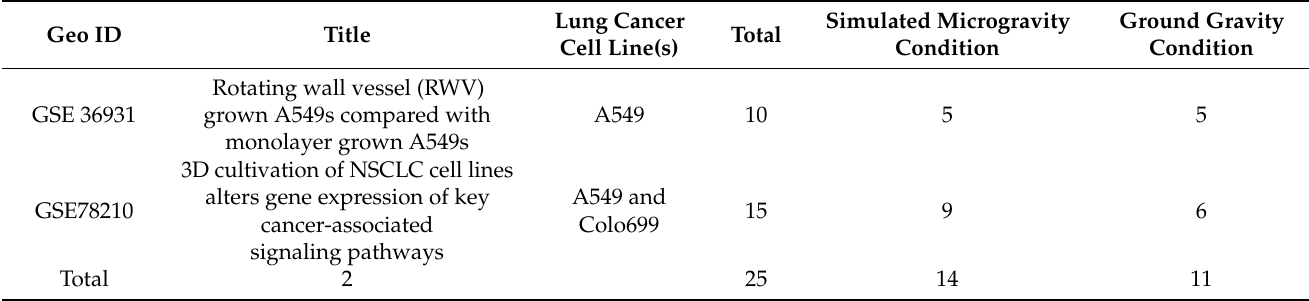
Table 2. Details of Datasets Extracted from Gene Expression Omnibus (GEO) used for Initial